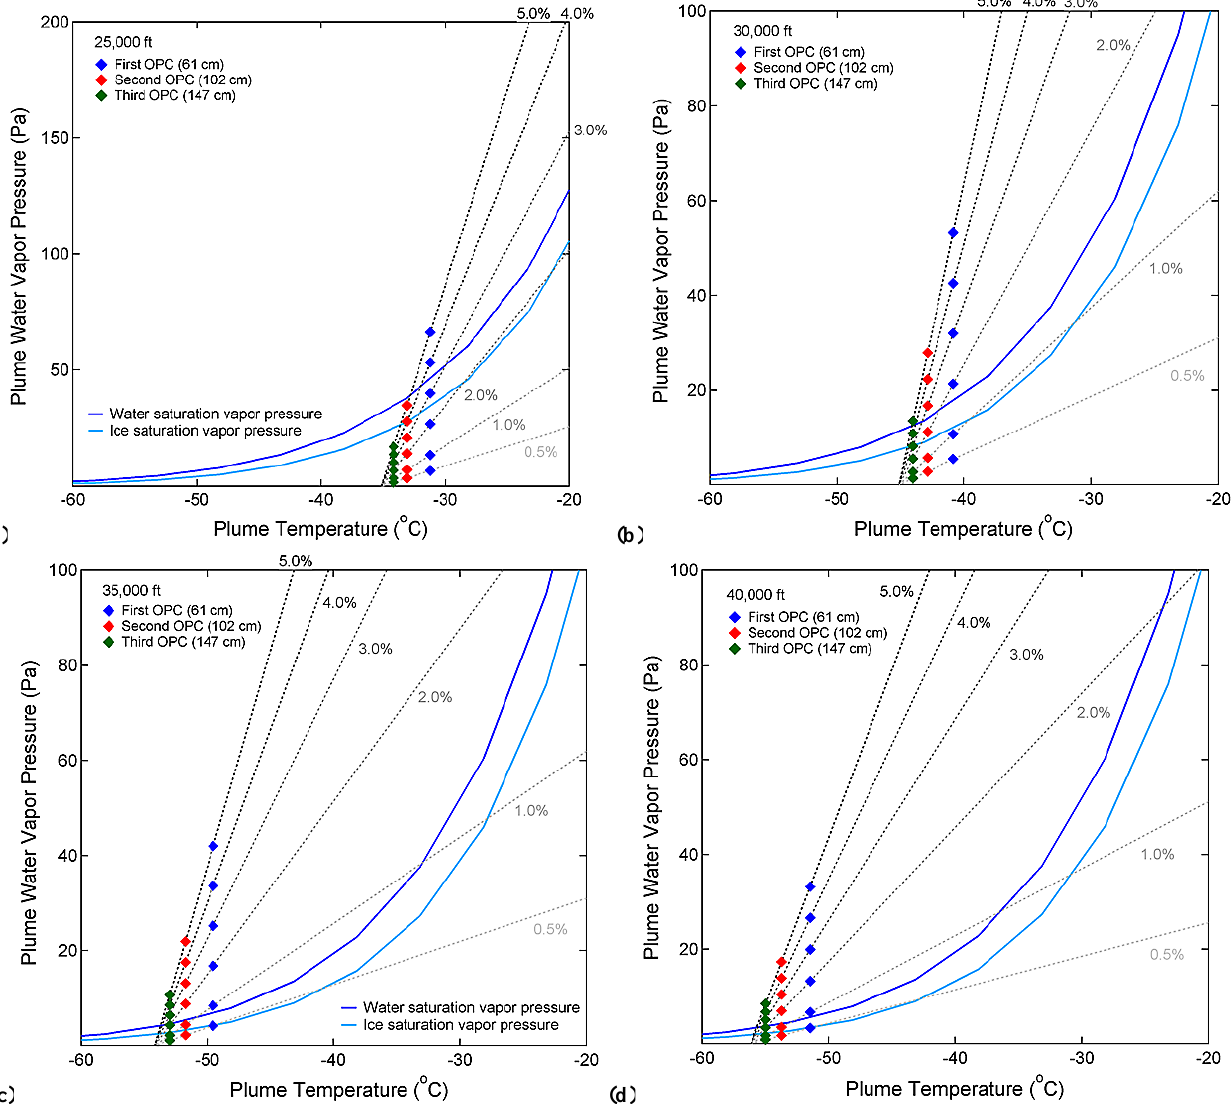
Fig. 2. Water and ice saturation vapor pressure curves, plume mixing lines for exhaust water levels between 0.5–5% in molar fraction, and plume temperature and water vapor pressure at the three sampling locations derived from the tracer measurements under (a) 25000, (b) 30000, (c) 35000, and (d) 40000ft standard day conditions in the PAL